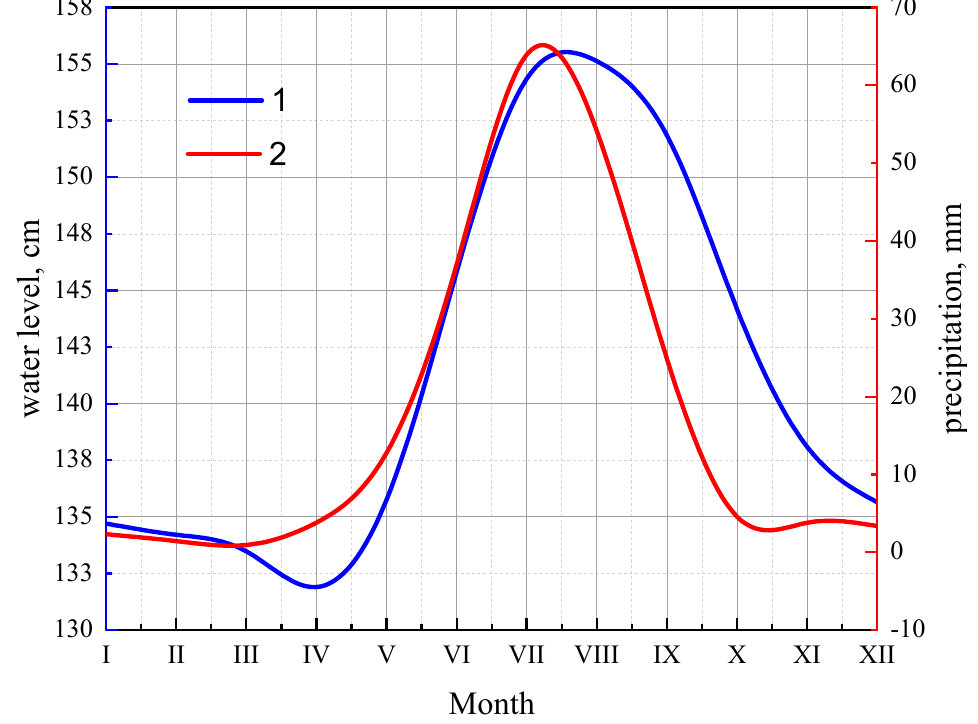
Figure 5. Monthly averages of the water level ( 1 ) in Lake Gusinoe and precipitation ( 2 ) during the period of 1970–2020.